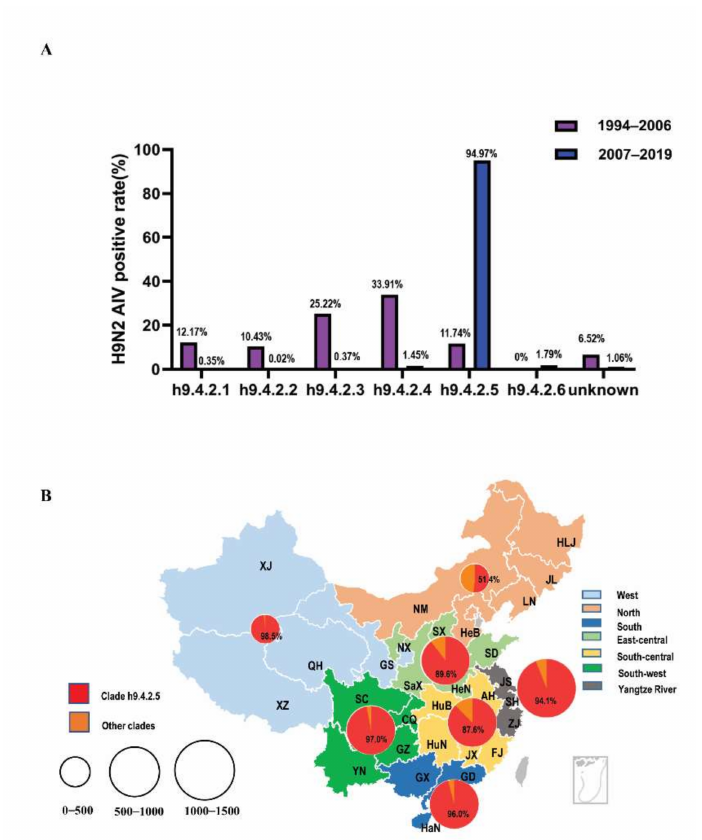
Figure 2. H9N2 AIV sampling sites and isolation rates in Chinese provinces from 1994–2019. ( A ) 23 provinces, 5 municipalities, and 4 minority autonomous regions in China were divided into 7 different regions: West (Gansu, GS; Xinjiang, XJ; Qinghai, QH; and Xizang, XZ; light blue). North (Heilongjiang, HLJ; Inner Mongolia, NM; Hebei, HeB; Liaoning, LN; and Jilin, JL; pink), South (Guangxi, GX; Guangdong, GD and Hainan, HaN; blue), East-Central (Shandong, SD; Shaanxi, SaX; Shanxi, SX; Henan, HeN and Ningxia, NX; light green), South-Central (Anhui, AH; Hubei, HuB; Jiangxi, JX; Hunan, HuN and Fujian, FJ; yellow), South-West (Sichuan, SC; Guizhou, GZ; Chongqing, CQ and Yunnan, YN; green), Yangtze River Delta (Jiangsu, JS; Shanghai, SH; and Zhejiang, ZJ; black). The red portion in each pie chart indicates the isolation rate of clade h9.4.2.5 in this region; the isolation rate of the other clades was represented by dark yellow. Different sample sizes were represented by circles of different sizes. ( B ) The AIV positive rates from 1994–2006 were represented by purple; the AIV positive rates from 2007–2019 were represented by blue. The regions included West, South, North, East-Central, South-Central, South-West, and Yangtze River. The numbers on the column represent the AIV isolation